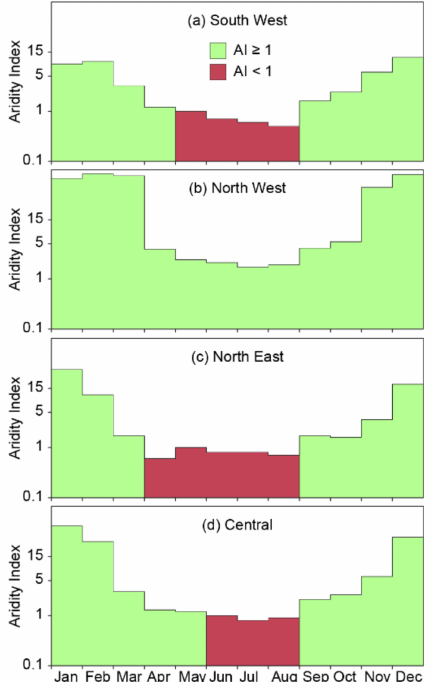
Figure 2. Calculated aridity index for individual regions: ( a ) South West; ( b ) North West; ( c ) North East; ( d ) Central region. Green and red areas indicate the cold / rainy and the warm / dry months,